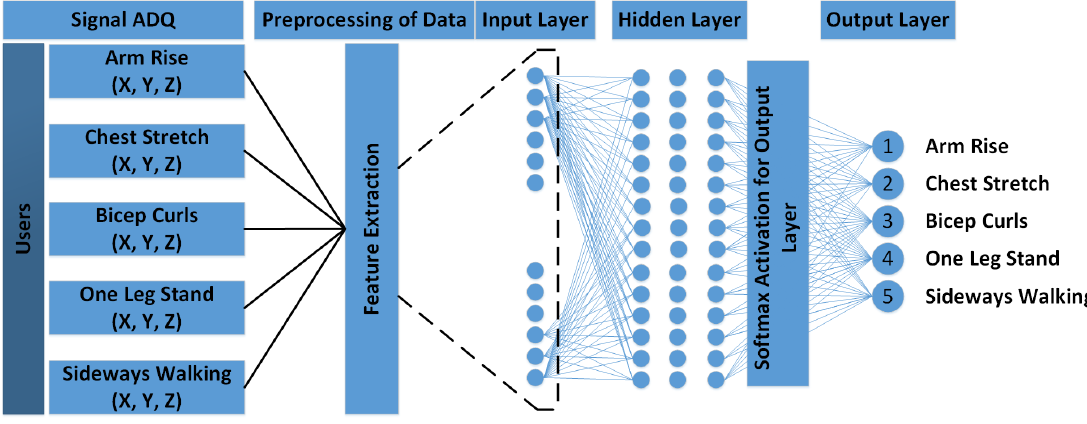
Figure 7. Structure of the 1D CNN used to classify